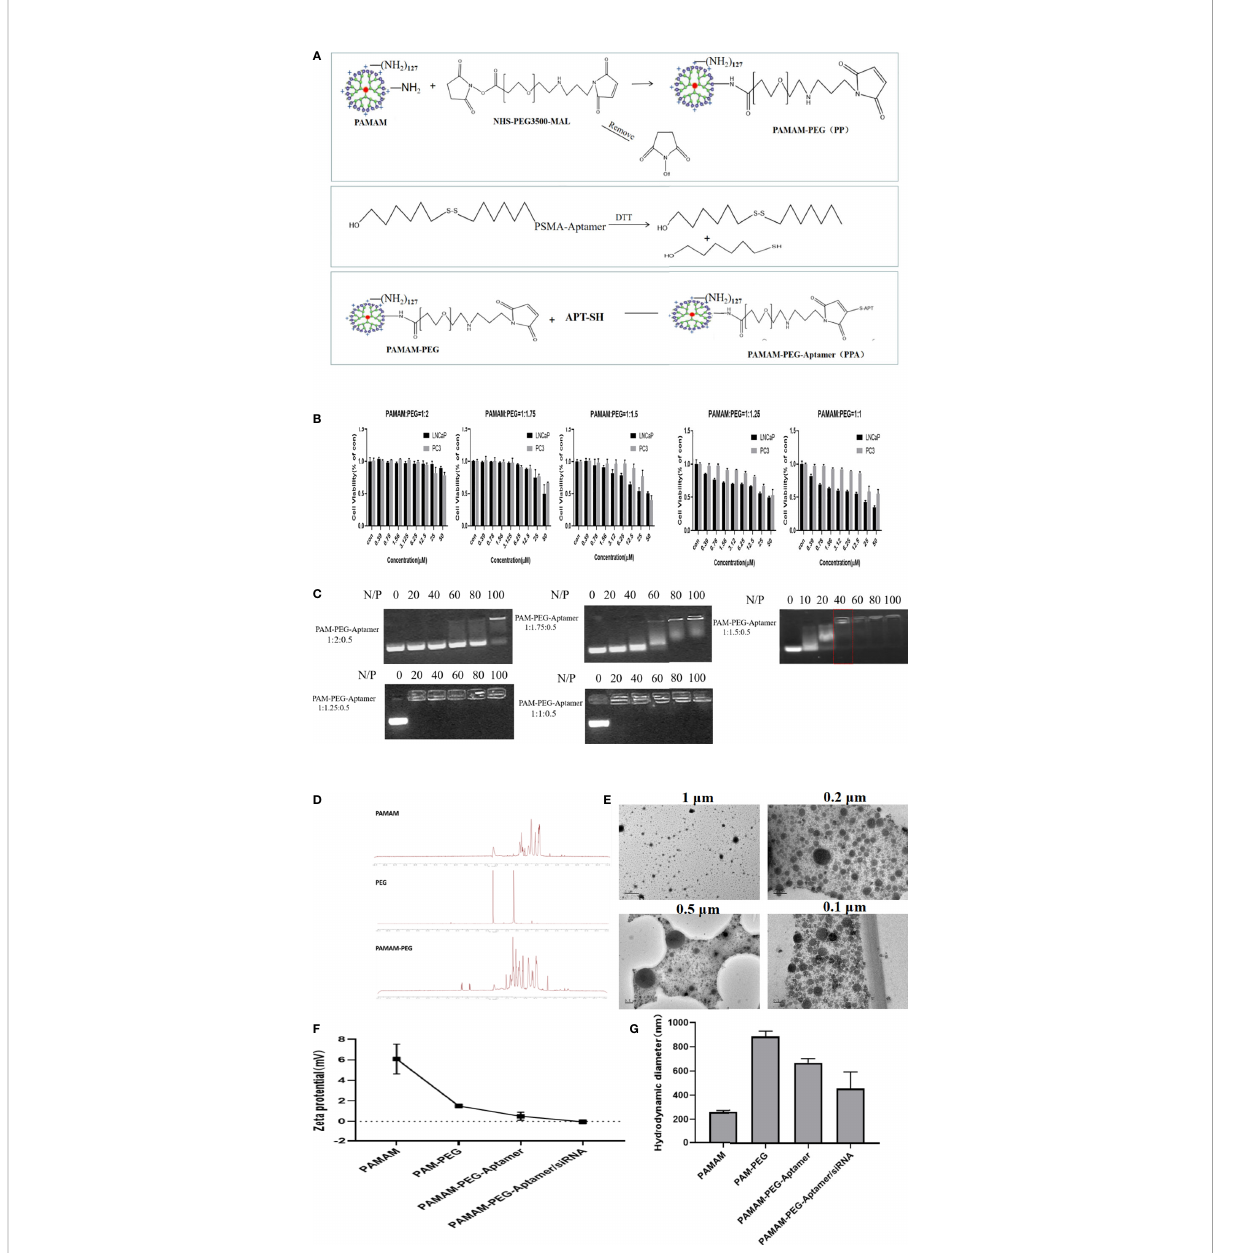
FIGURE 2 Construction and characterization of complex nucleic acid nanoparticles. (A) Schematic Illustration of siAKR1C3@PPA composition and assembly. (B) Evaluation of the safety of PP in LNCaP and PC3 cells. Data are presented as the mean ± SD, n=6. (C) The optimum ratio of the nucleic acid nanoparticle complex. (D) Magnetic spectrum of PAMAM, PEG and PAMAM-PEG. (E) Transmission electron microscopy